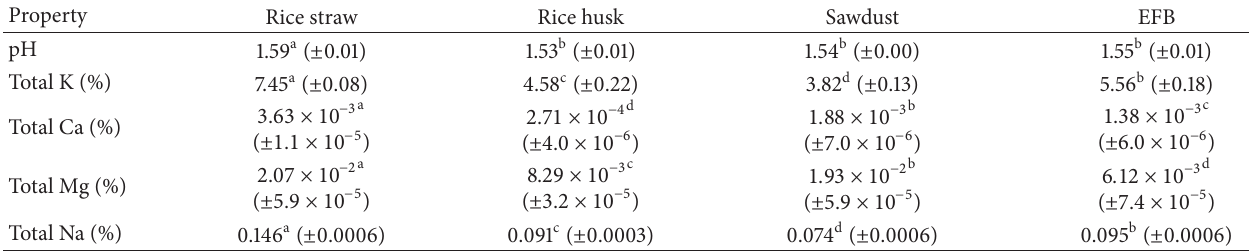
Table 6: pH and major cation contents (mgkg − 1 ) of crude fulvic acids from different composts.